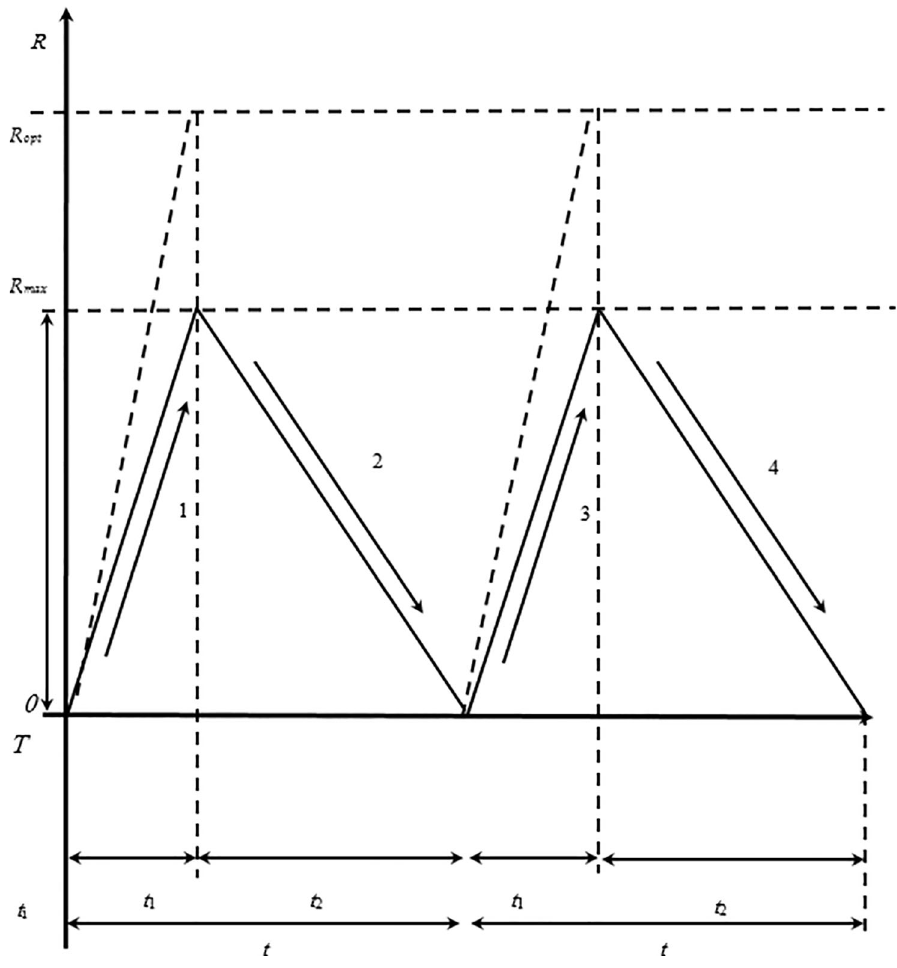
Figure1.Changeinthecashbalanceaccordingtotheproposedcashflowmodel:1, 3:proposedcashflowover time at the expense of funds received from the sale of securities; 2, 4: spending of the cash reserve on payments with a total volume of